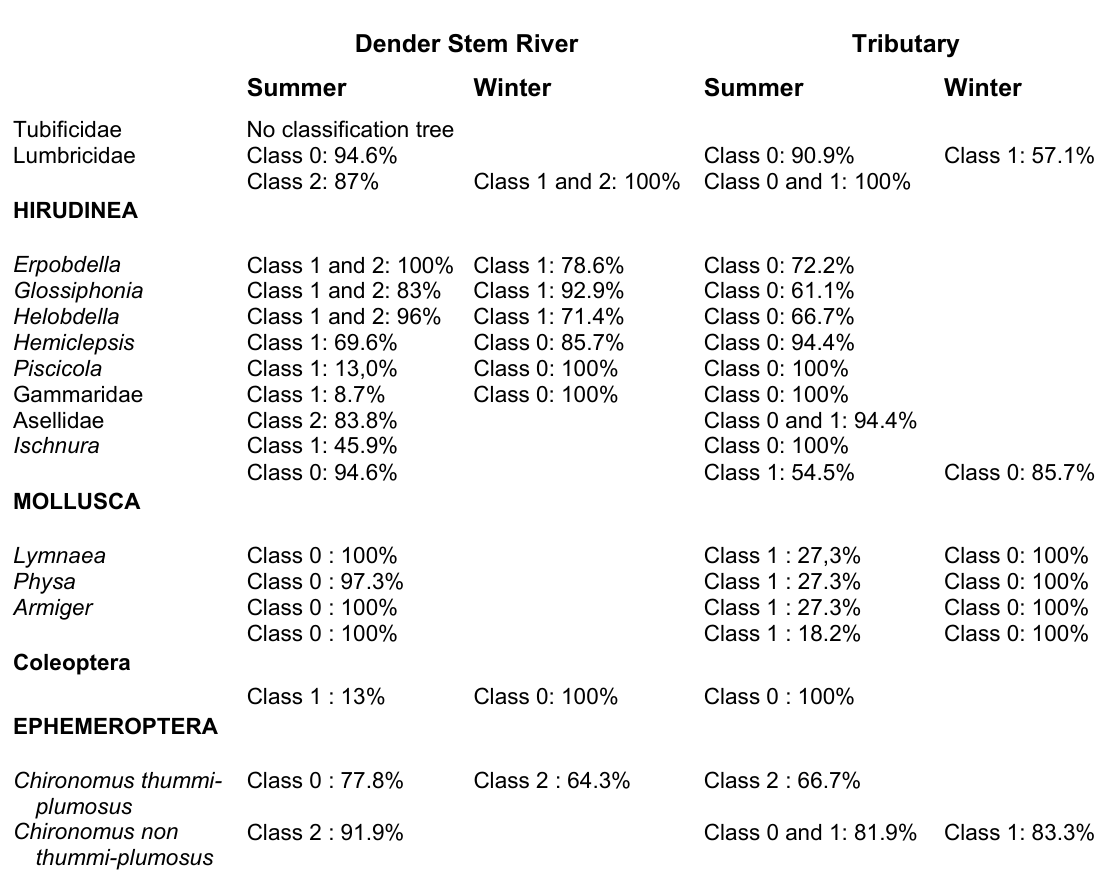
Classification of Macroinvertebrate Taxa According to River Type and Season (Class 0